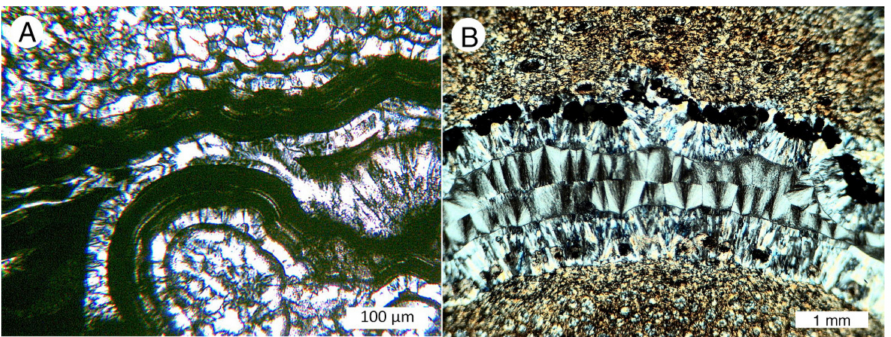
Figure 9. Polarized light images of chalcedony filling open spaces in fossil wood. ( A ) Miocene, Blowout Mtn., Virgin Valley area northern Nevada, USA. The dark layers are opal-A. This texture is evidence that opal-A and opal-CT were produced by cyclic precipitation, where the two polymorphs were repeatedly deposited as alternating layers. ( B ) Fracture containing chalcedony layers precip- itated in two layer pairs. Both sequences show patterns of radiating fibers, with a coarse pattern present in the innermost layers. Eocene, Blue Forest locality, Eden Valley, Wyoming, USA. Specimen from Mike